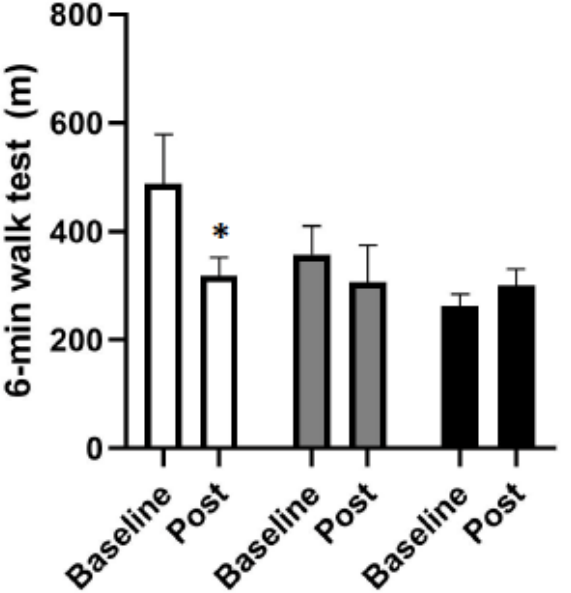
Figure 2. Functional capacity. Six-minute walk test (6-MWT); m: meters; * p < 0.05, significantly different from baseline.